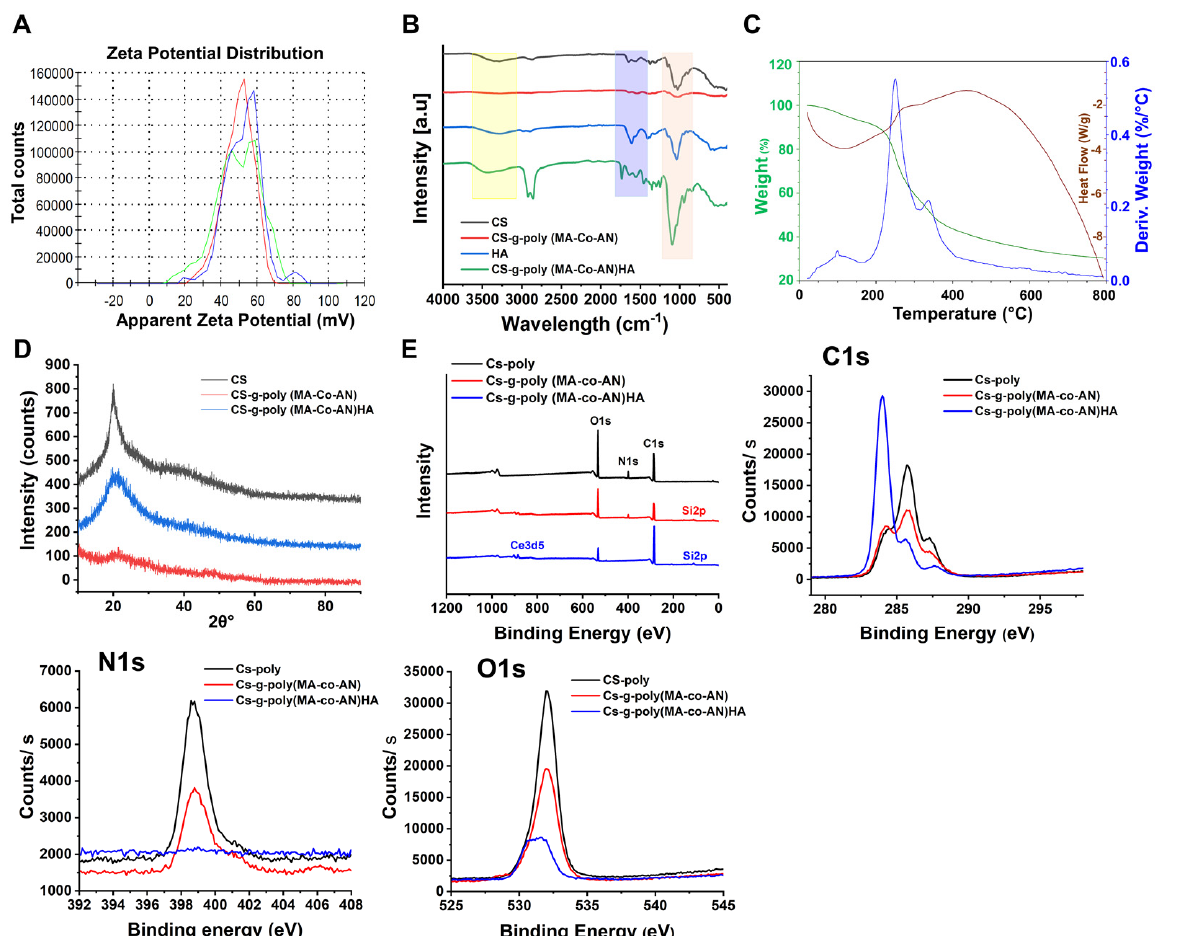
Figure 1. Characterization of the CS-g-poly and CS-g-poly(MA-co-AN) HA; ( A ) zeta potential (mV) of CS-g-poly (MA-Co-AN), ( B ) FTIR analysis (black, red, blue, and green colors show the CS, CS-g-poly (MA-co-AN) HA, and CS-g-poly(MA-co-AN) HA, respectively), ( C ) simultaneous DSC − TGA of CS-g-poly (MA-Co-AN) HA, ( D ) XRD analysis of CS-g-poly, CS-g-poly (MA-Co-AN), and CS-g-poly (MA-Co-AN)-HA (black, red, and blue show the CS, CS-g-poly (MA-Co-AN), and CS-g-poly(MA-Co-AN) HA, respectively), ( E ) XPS analysis of CS, CS-g-poly (MA-Co-AN), and CS-g-poly (MA-Co-AN)-HA, and their C1s, N1s, and O1s binding energy spectra, (black, red, and blue show the CS, CS-g-poly (MA-Co-AN), and CS-g-poly(MA-co-AN) HA, respectively). Figure 1B shows the FTIR spectra of CS, HA, CS-g-poly (MA-Co-AN), and CS-g-poly (MA-Co-AN) HA. For CS, OH stretch was observed at 3285.68 cm − 1 . This peak was broadened due to overlap with the NH peak at 3357 cm − 1 . The peak at 2870.4 cm − 1 was attributed to C-H asymmetric stretch and the peak at 1152.6 cm − 1 to an asymmetric stretch of C-O-C bridges. C-O stretch was observed at 1028.30 cm − 1 , and N-H bending of primary amines at 1645.7 cm − 1 . Extensional vibration of the CH band was observed at 1555.4 cm − 1 . CS-g-poly (MA-Co-AN) showed a broad stretch peak at 3292.6 cm − 1 of low intensity because the NH groups of the monomers overlapped with the hydroxyl groups of CS. C-H asymmetric stretch was observed at 2873.6 cm − 1 . CN and primary amine N-H bending vibrations were observed at 1247.5 cm − 1 and 1642.4 cm − 1 , respectively. The C-O stretching band was observed at 1020.4 cm − 1 . In the FTIR spectra of HA, the broad peak at 3276.32 cm − 1 was attributed to O-H vibration and the peak at 2896 cm − 1 to asymmetric vibration of C-H. The sharp peak at 1609.07 cm − 1 was attributed to the carboxylic group of HA. The FTIR spectra of CS-g-poly (MA-Co-AN) HA had a broad OH peak at 3471 cm − 1